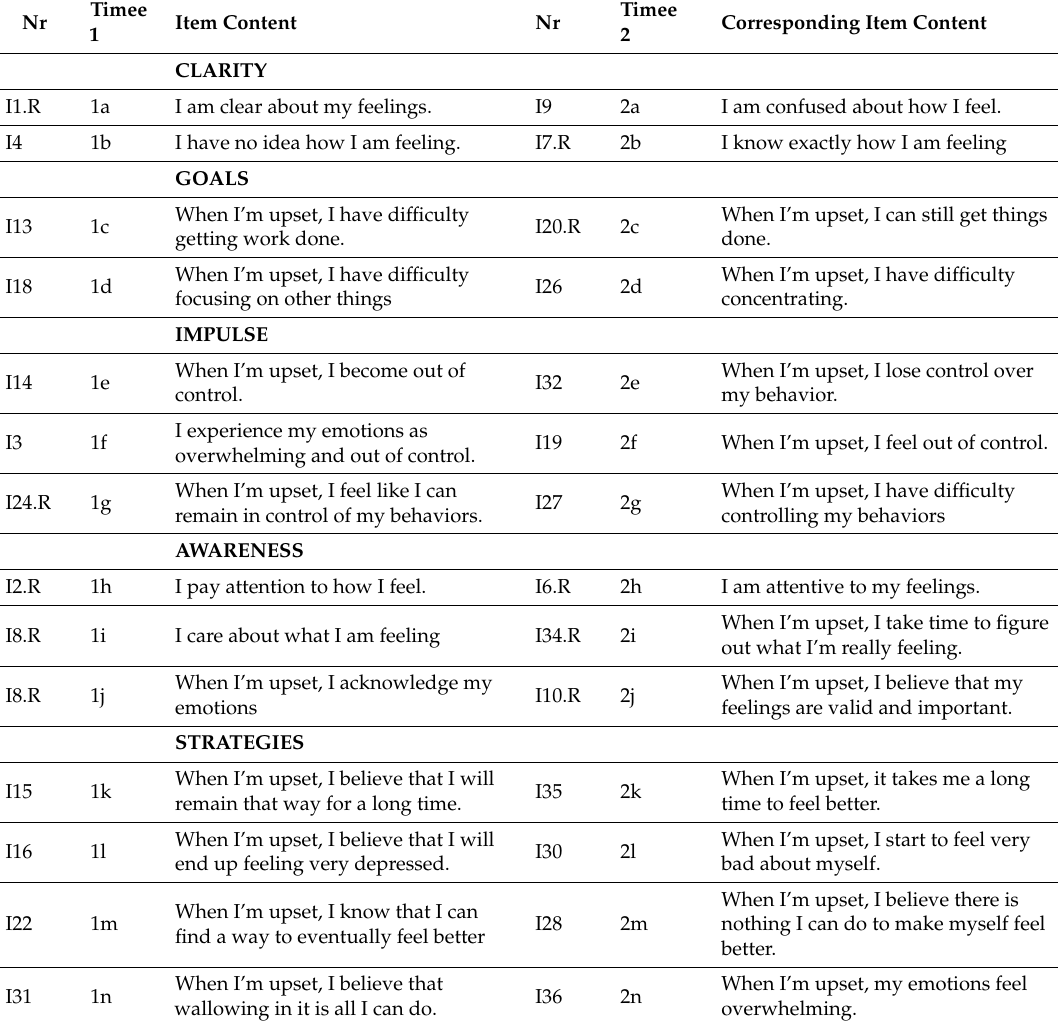
Table 2. Item correspondence; R = reverse